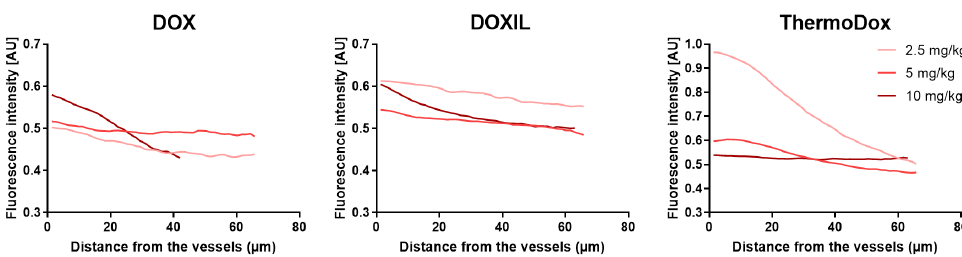
Figure 4. Doxorubicin intensities relative to the vessels over the whole tumor. The doxorubicin intensity relative to the vessels was determined after DOX ( A ), DOXIL ( B ), and ThermoDox ( C ) treatment at injected doses of 2.5, 5, and 10 mg/kg.